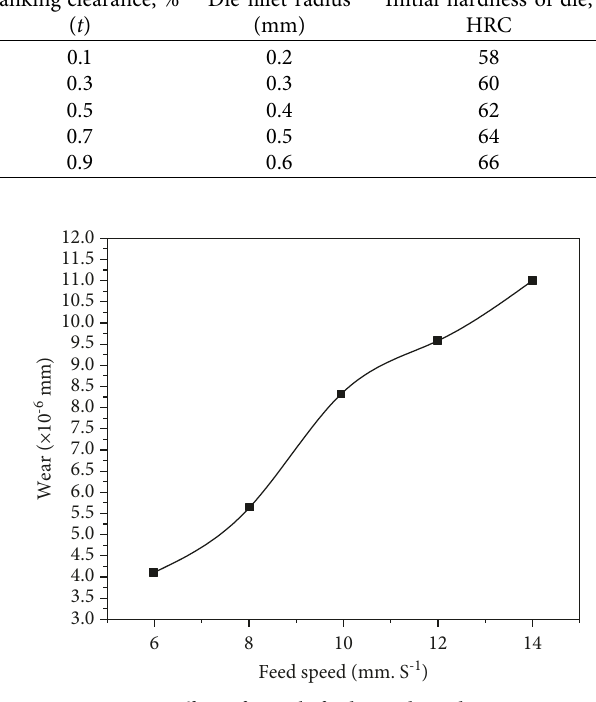
Figure 5: Effect of punch feed speed on die wear.